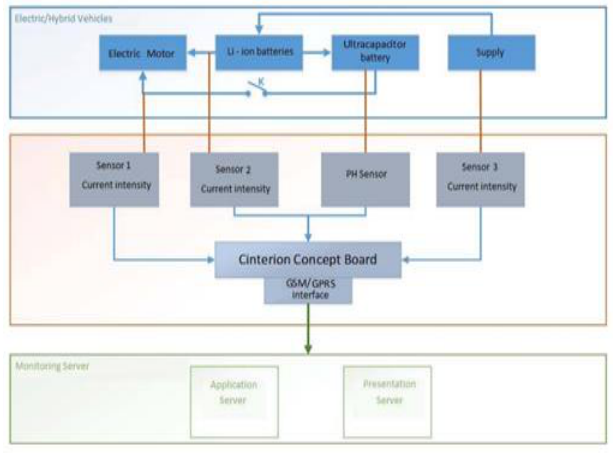
Figure 1. Conceptual design of the tele-monitoring